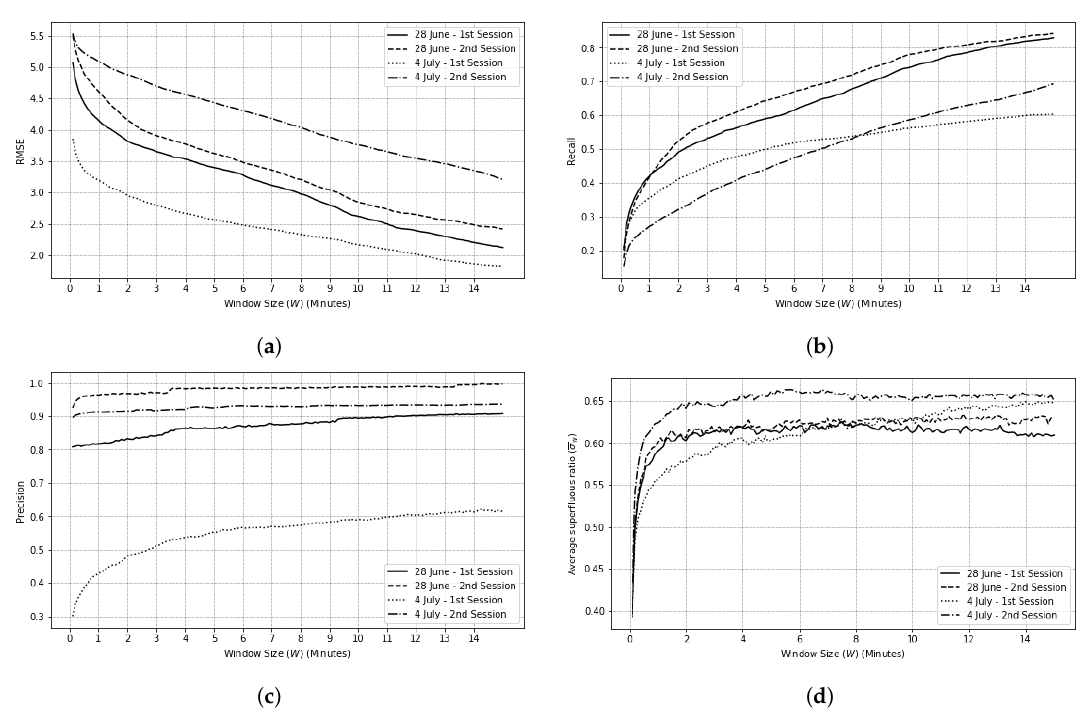
Figure 9. SAS analysis for beacon sensors for different window sizes. ( a ) RMSE value, ( b ) recall value, ( c ) precision value, ( d ) superfluous